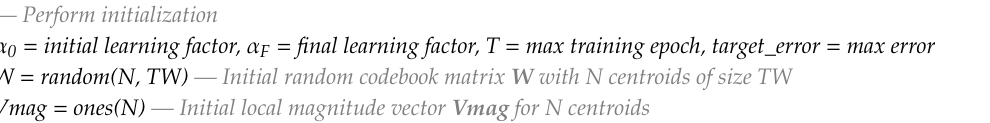
Algorithm 1. Adaptative VQ